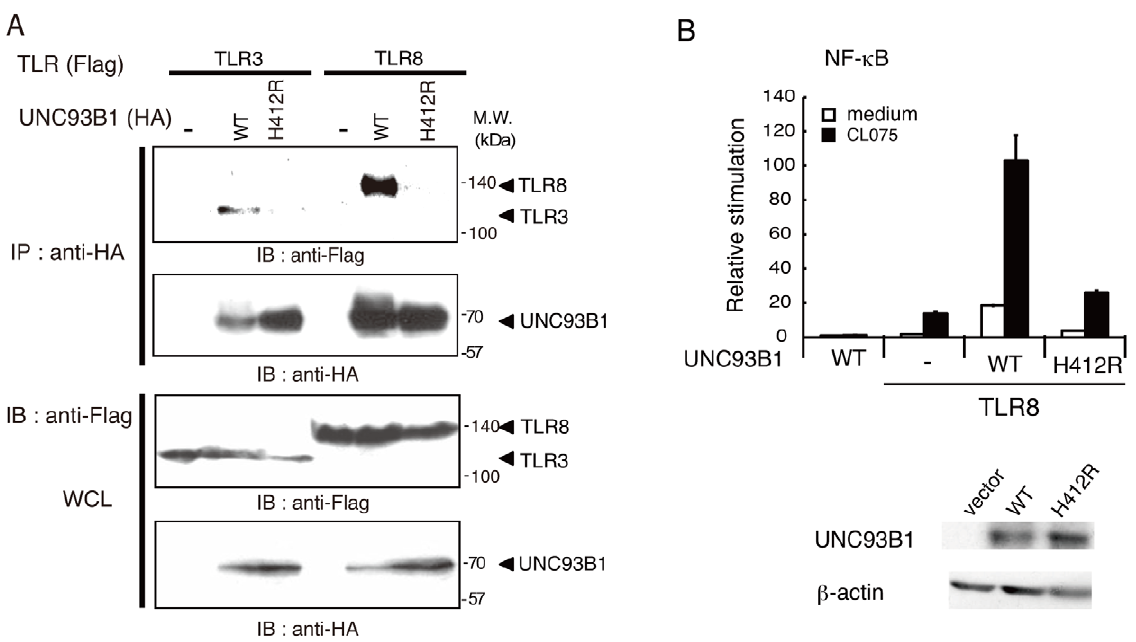
Figure 6. His412 is essential for the interaction of UNC93B1 with TLR8 and TLR8-mediated signaling. A , HEK293FT cells were transfected with the corresponding vectors for expression of the indicated proteins. The cell lysates were immunoprecipitated (IP) with anti-HA pAb, resolved by SDS-PAGE and detected by immunoblotting (IB) with anti-FLAG M2 or anti-HA mAb. Whole cell lysates (WCL) were subjected to immunoblotting with anti-FLAG or anti-HA mAb to detect protein expression. Molecular weight markers are shown on the right. B , HEK293 cells were transfected with the indicated plasmid together with the ELAM reporter plasmid. Cells were stimulated with CL075 or left untreated and the luciferase reporter activities were measured. Representative data from three separate experiments are shown. Lower panels, protein expression of wild-type and mutant UNC93B1 in HEK293 cells. b -actin blots are shown as loading controls.